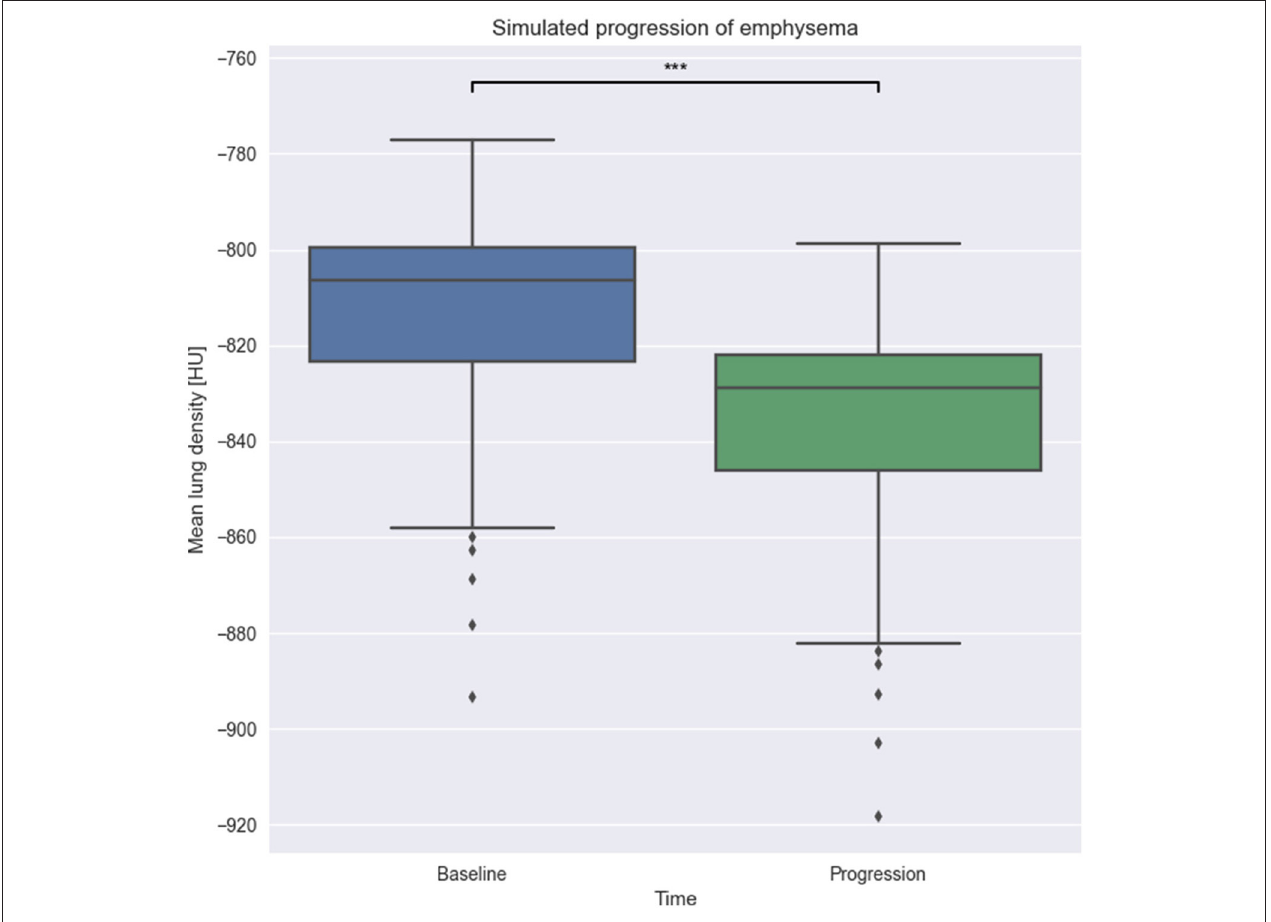
FIGURE 8 | Effect of model execution. We run our emphysema progression model on 69 patches with low emphysema until completion. As expected, the resulting patches have a lower MLD than the original one, showing parenchyma destruction during model run. *** p -value <